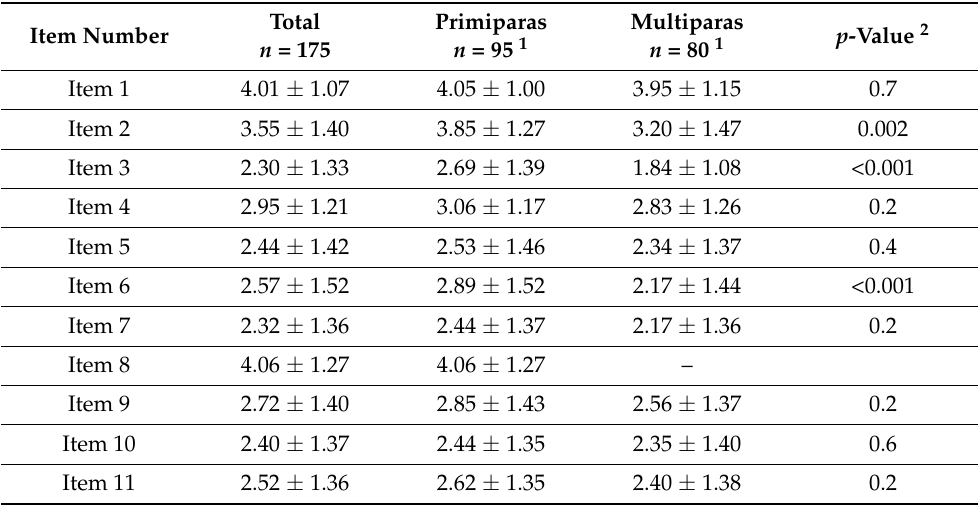
Table 2. Mean values of PRAQ-R2 items and significant differences between nulliparous and parous women.